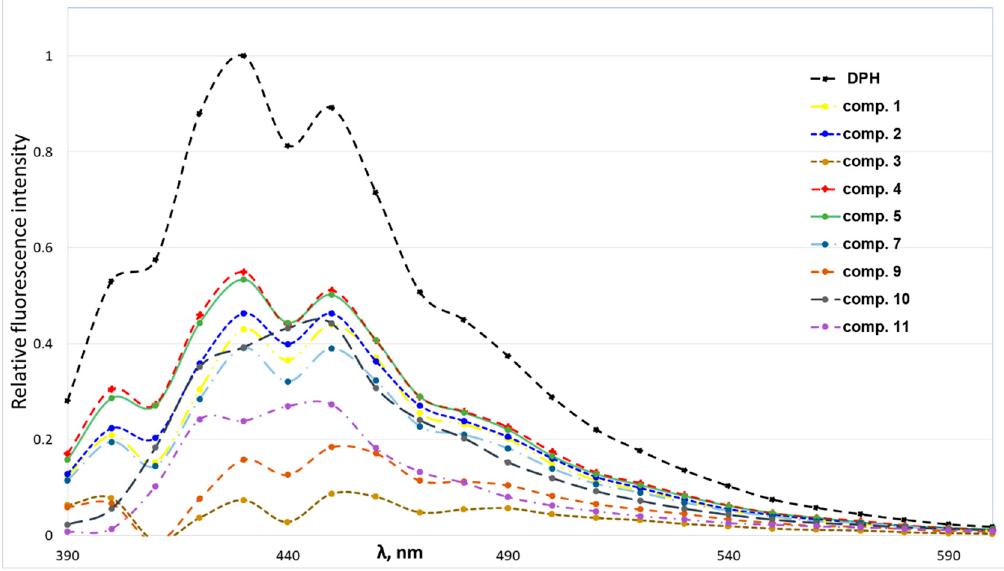
Figure 4. Fluorescence intensity spectra of solutions containing 1,2-dipalmitoyl-sn-glycero-3- phosphocholine (DPPC) (2 × 10 − 5 M) and 1,6-diphenyl-1,3,5-hexatriene (DPH) (5 × 10 − 6 M) in the